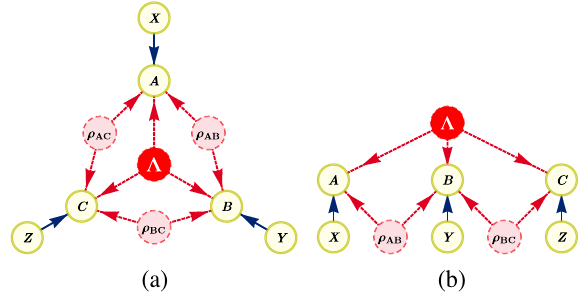
FIG. 13. (a) The quantum triangle scenario with settings and shared randomness, sometimes denoted Q △ þ SR for brevity. (b) The quantum tripartite-line scenario with shared randomness, sometimes denoted for brevity. Such “ hybrid ” DAGs denote the presence of quantum sources along with the presence of a classical source of shared randomness. The classical latent node is denoted Λ and is depicted in white text on a dark red background to distinguish it from the other quantum latent nodes. Though Q △ þ SR is inequivalent to Q △ depicted in Fig. 10, and similarly is inequivalent to depicted in Fig. 11, nevertheless both causal structures in each pair are equivalent up to linear-function